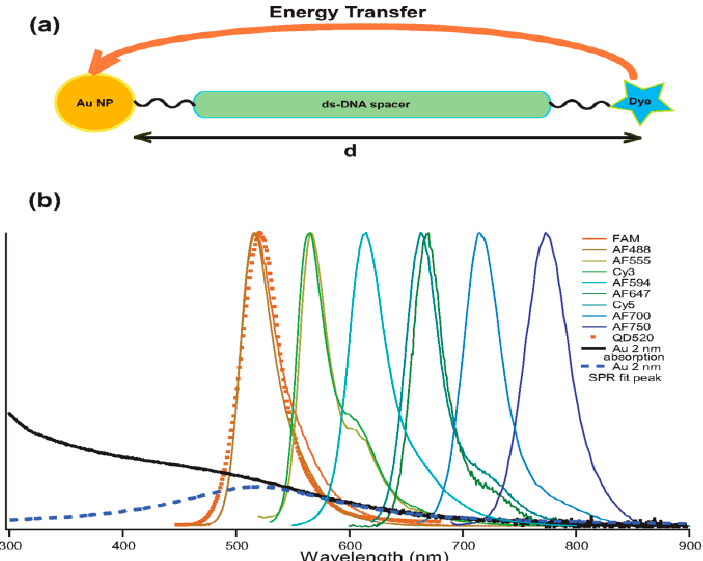
Figure 21. ( a ) Energy transfer schematic drawing. ( b ) Normalized donors(cid:31) PL spectra and the ex- tinction of AuNPs [92]. extinction of AuNPs [92].